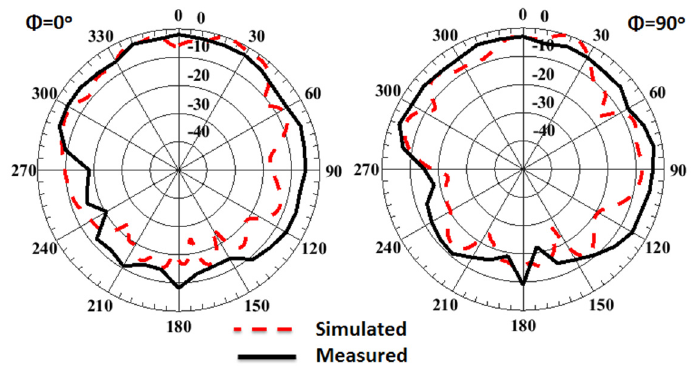
Figure 24. The normalized radiation pattern outcomes of the 4-port MIMO antenna with FSS at port 1 and 38 GHz.